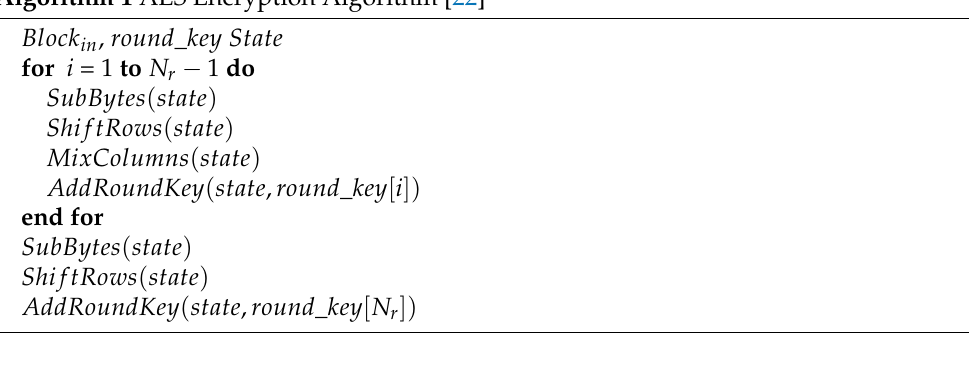
Algorithm 1 AES Encryption Algorithm [22]